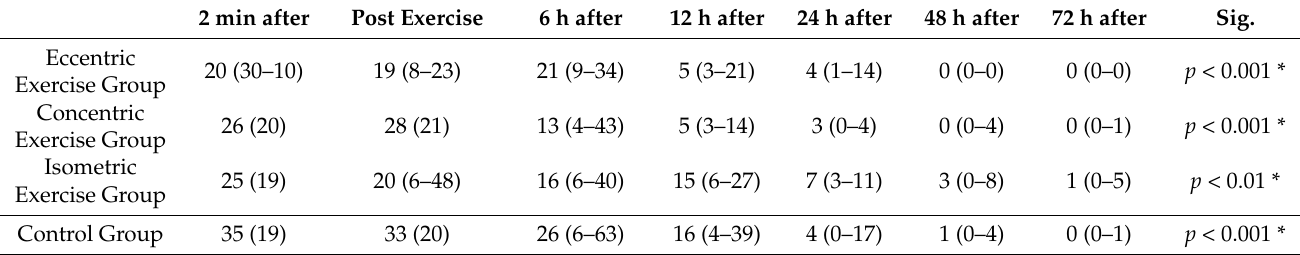
Table 2. Change in postneedling soreness intensity (pVAS, mm) over time within each group. 2 Min After Post Exercise 6 h After 12 h After 24 h After 48 h After 72 h After Sig.